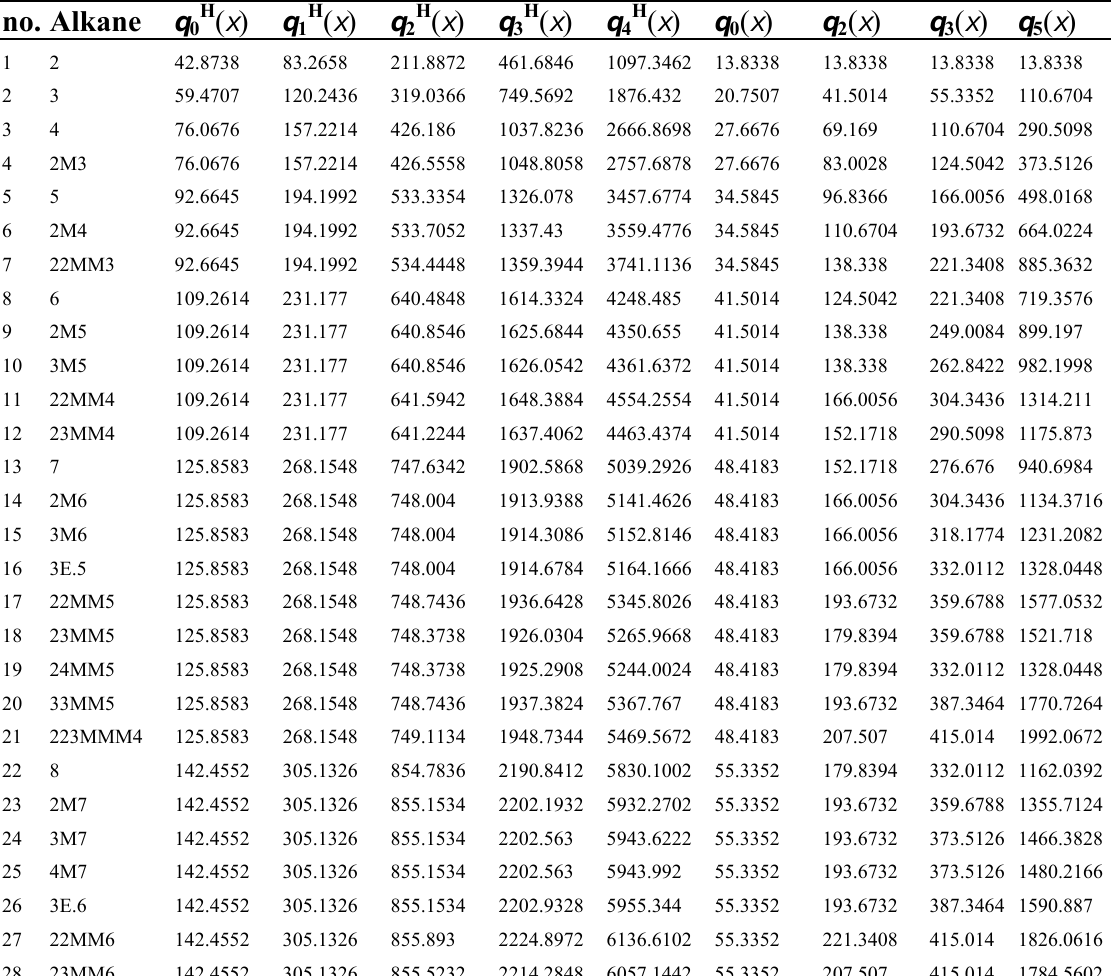
Table 4. Quadratic Indices of the (cid:147)Molecular Pseudograph(cid:146)s Atom Adjacency Matrix(cid:148) for C3-C9